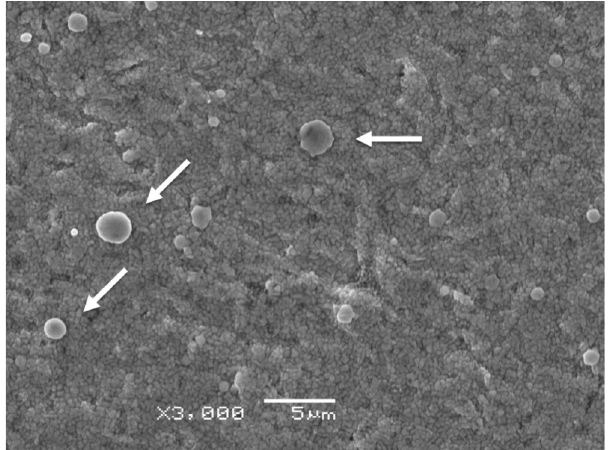
FIG. 4. SEM micrograph of a Pb film deposited on Nb, with an energy density of 1 : 0 J = cm 2 , a pulse duration of 7 ns, and a wavelength of 266 nm. The biggest droplets are indicated by arrows.